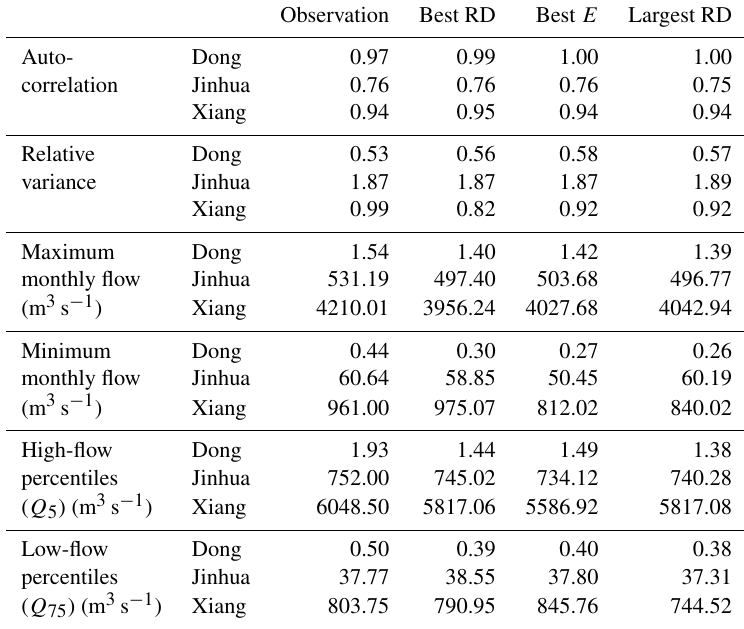
Table 2. Hydrological signatures of the typical models in all three cases.